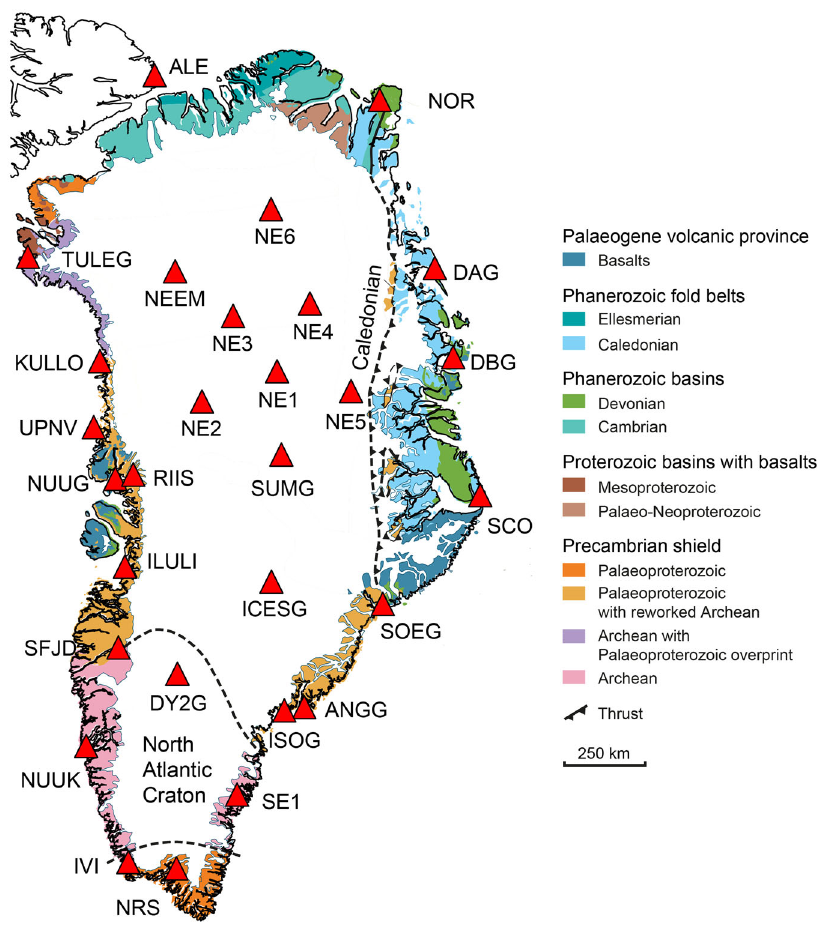
Fig. 1 Geological map of Greenland. Geological units are shown in colour (modi fi ed after Dawes 76 ) and the red triangles are the locations of the seismic stations used in this